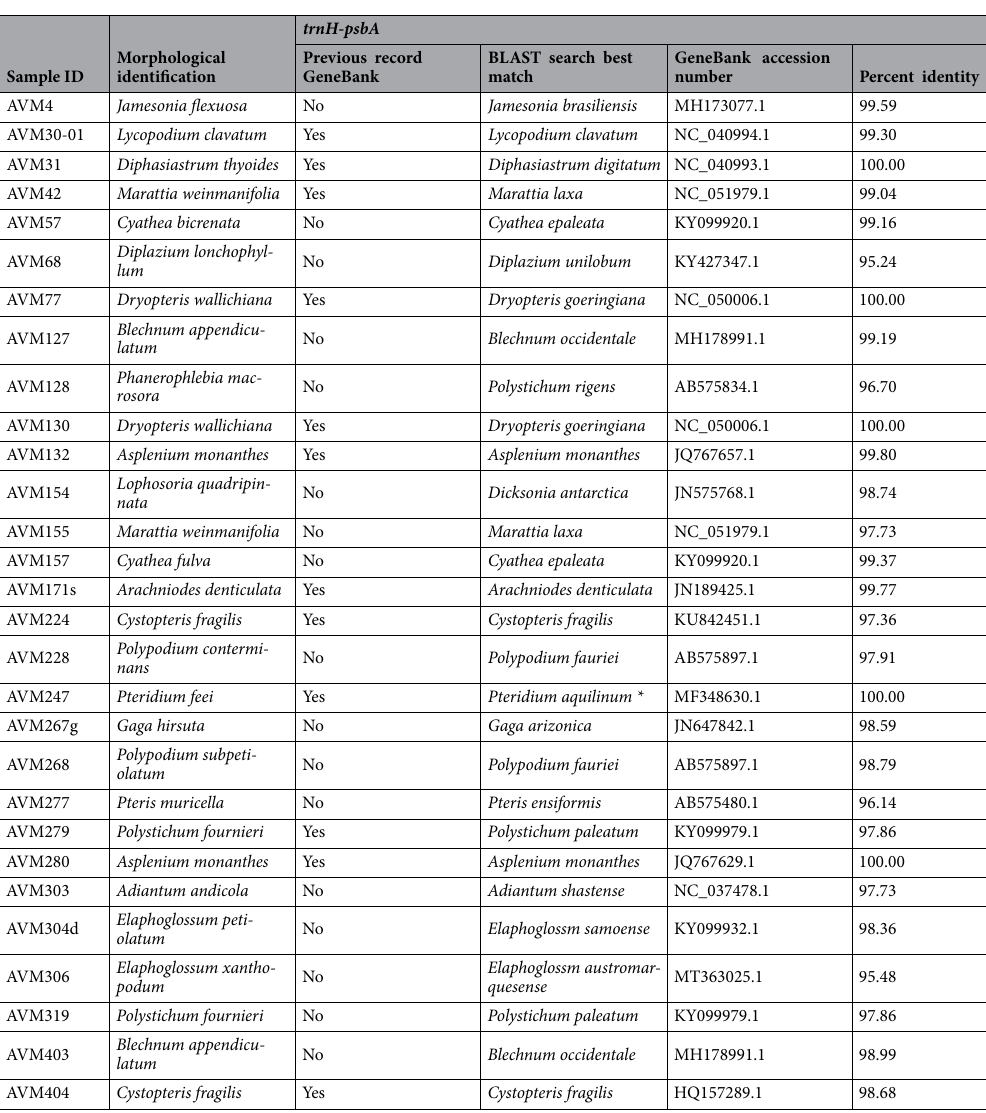
Table 5. BLAST search best match found on GeneBank for ferns and allies of the Mixteca Alta, Oaxaca, Mexico, using DNA sequences obtained from the intergenic spacer trnH-psbA . * Pteridium aquilinum is